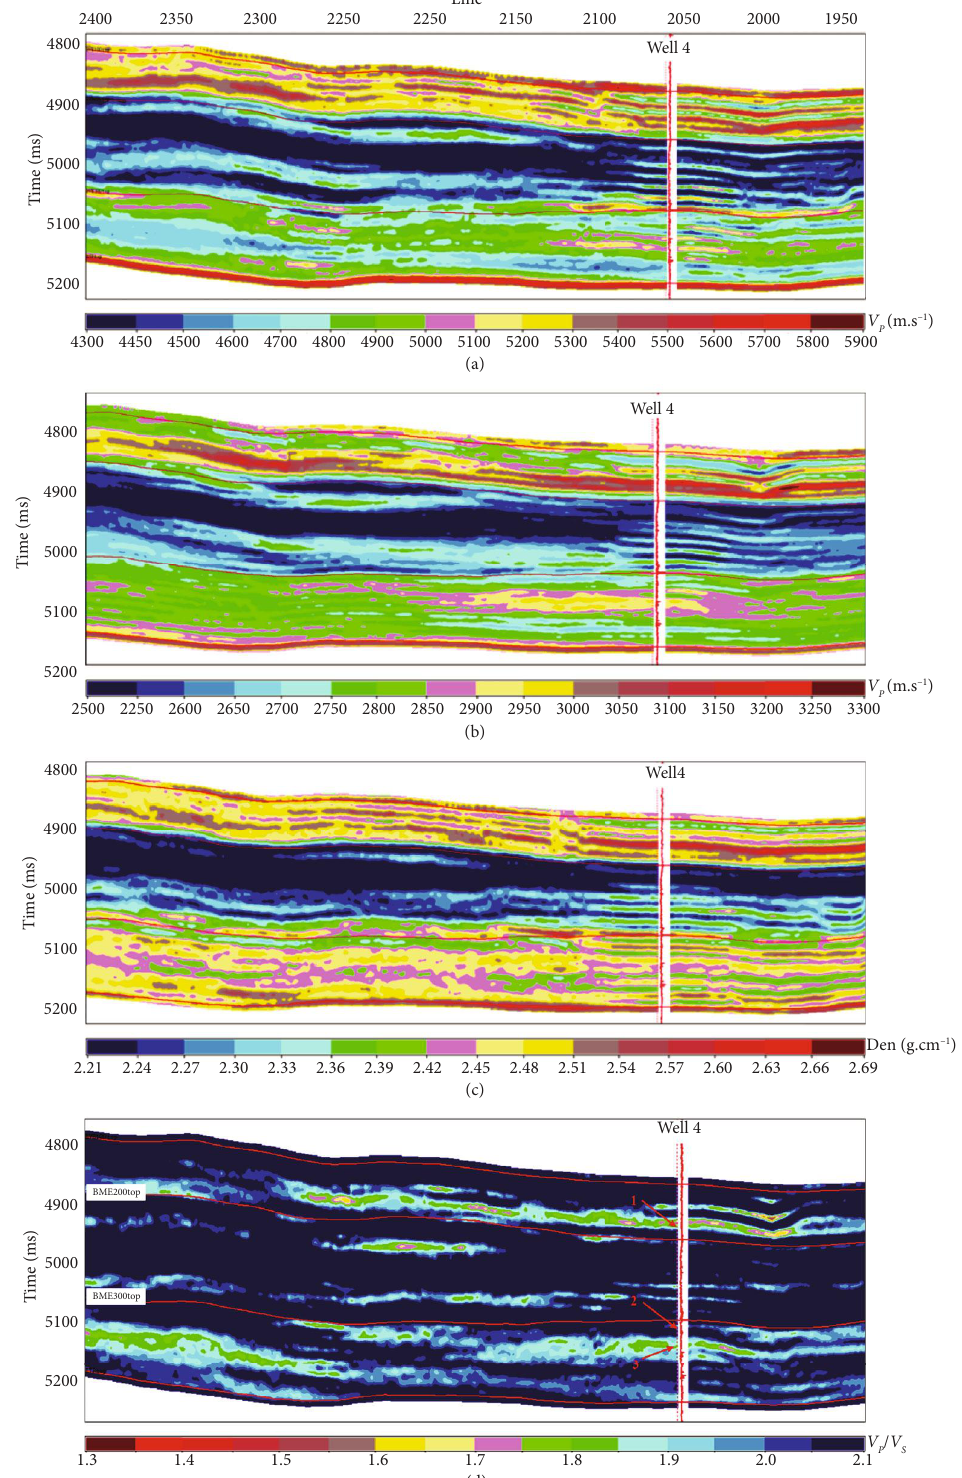
Figure 13: The prestack exact Zoeppritz equation inversion results of the (a) P-wave velocity, (b) S-wave velocity, and (c) density of well